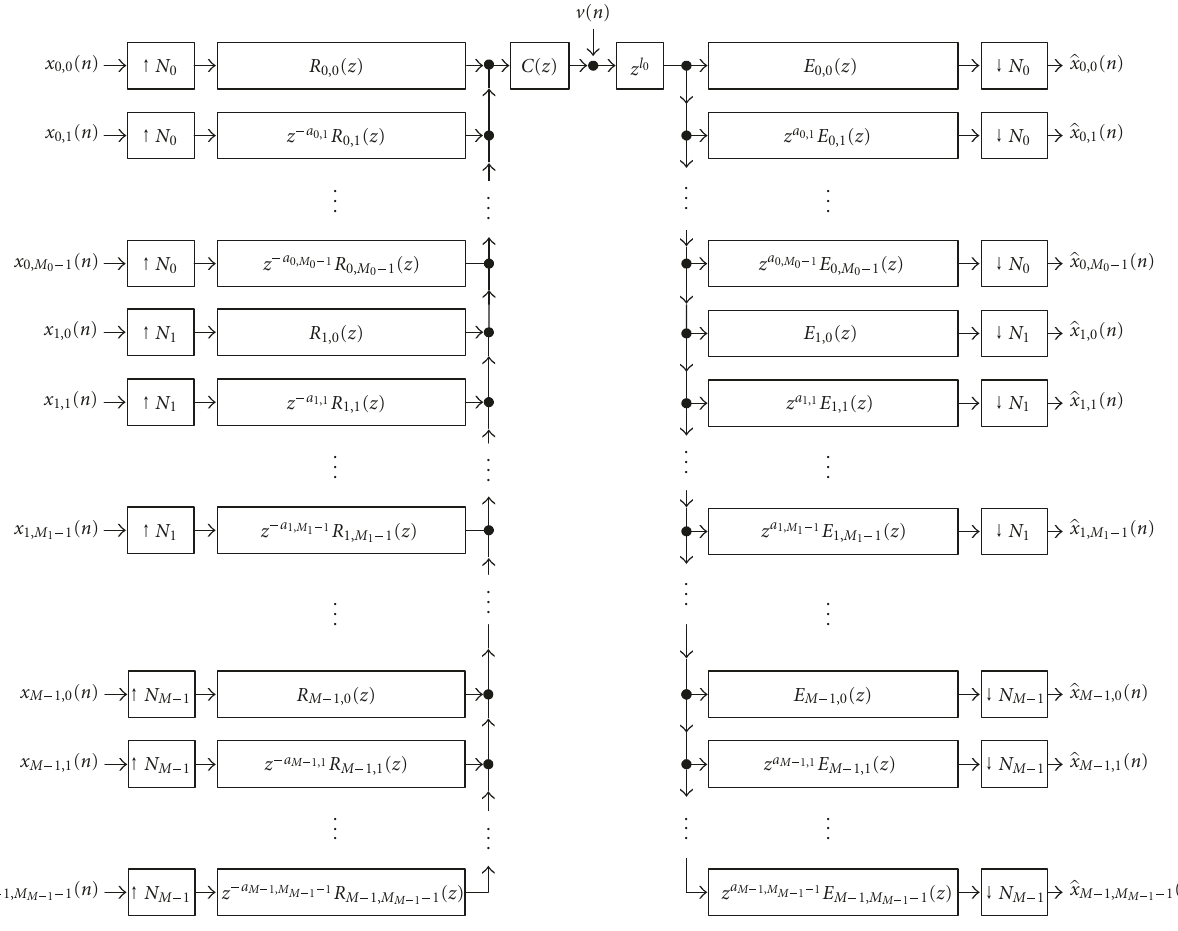
Figure 4: Equivalent circuit of the nonuniform filter bank transceiver with rational sampling factors in Figure 2.